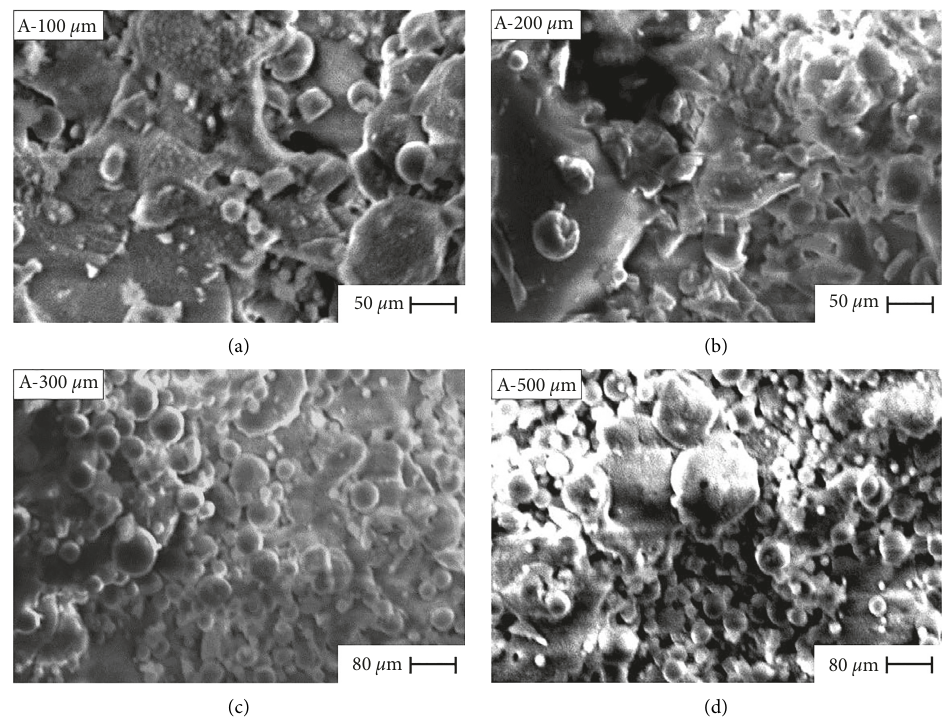
Figure 8: Surface microstructure of different thicknesses for coating. (a) 100 μ m. (b) 200 μ m. (c) 300 μ m. (d) 500 μ